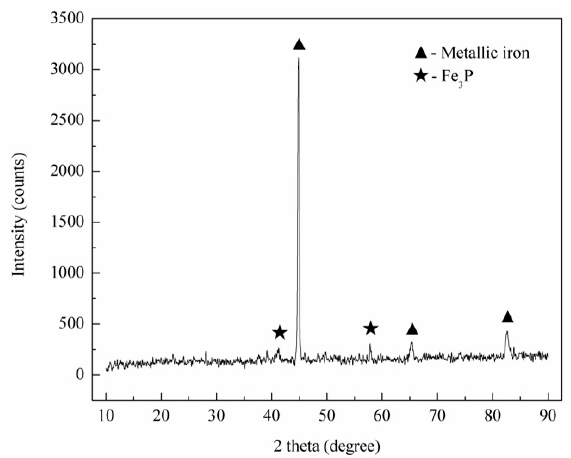
Figure 8. X-ray diffraction pattern of the reduced iron. Figure 8. X ‐ ray diffraction pattern of the reduced iron. Figure 8. X ‐ ray diffraction pattern of the reduced iron.